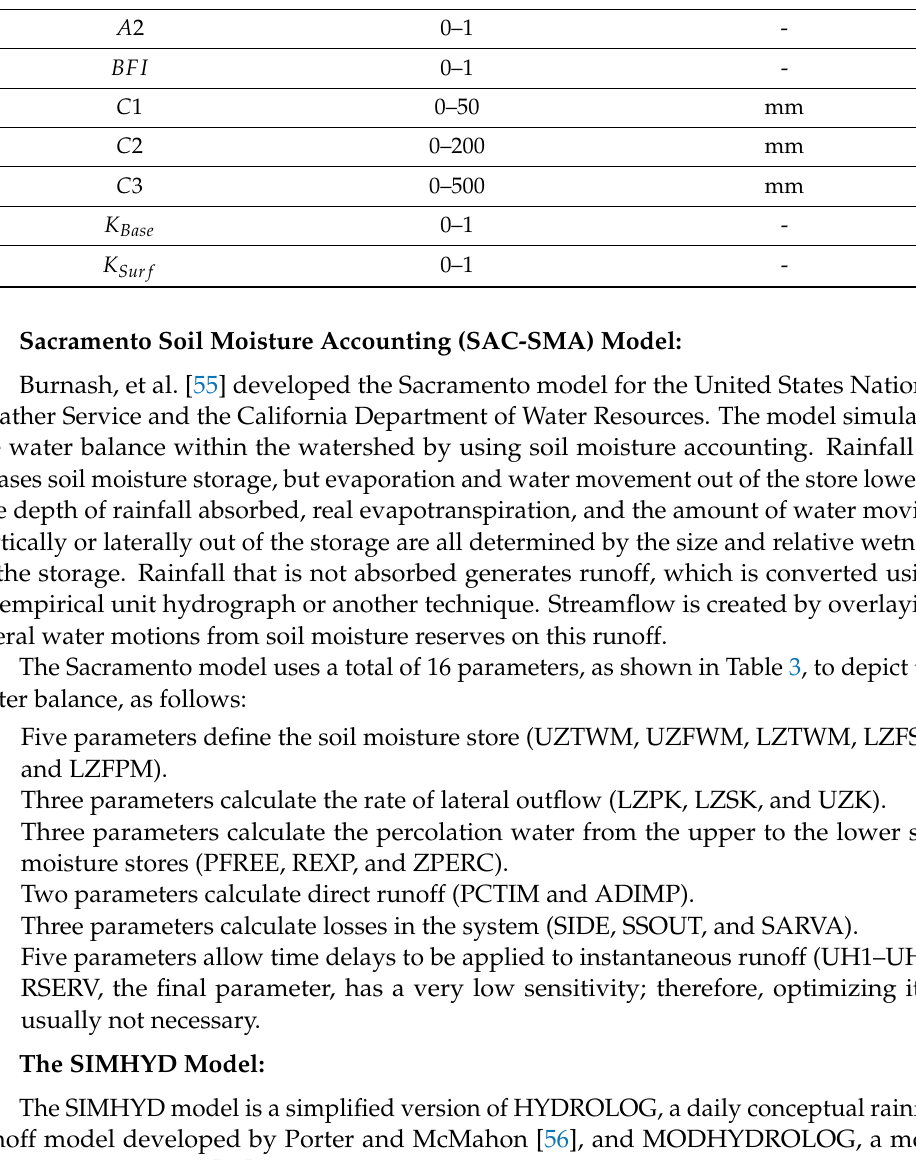
Table 2. Parameters of the AWBM and their ranges. AWBM Parameter Range Unit A 1 0–1 - A 2 0–1 -